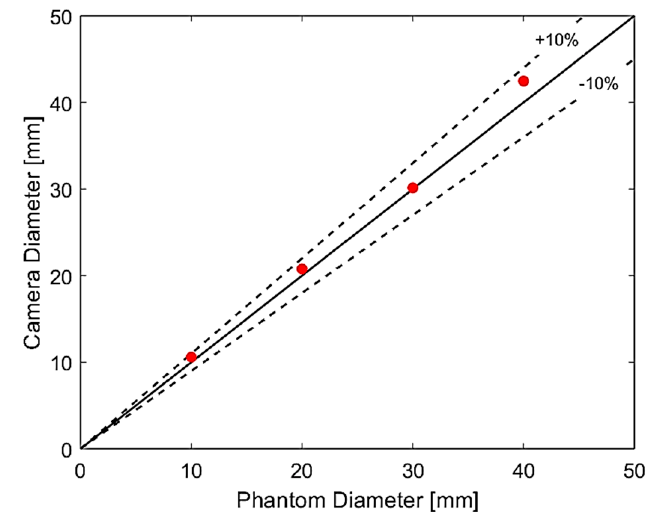
Figure 13. Comparison between phantom sizes and values recovered from camera images. The measured points are plotted in red, the continuous line represents a perfect match between the camera and the phantom size, and the dashed lines represent ±10% deviation lines around the average.